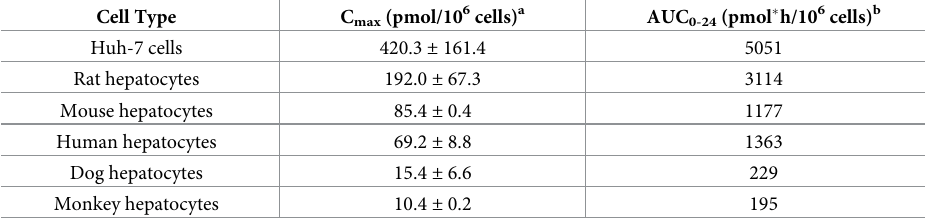
Table 7. Intracellular levels of AT-9010 in hepatic